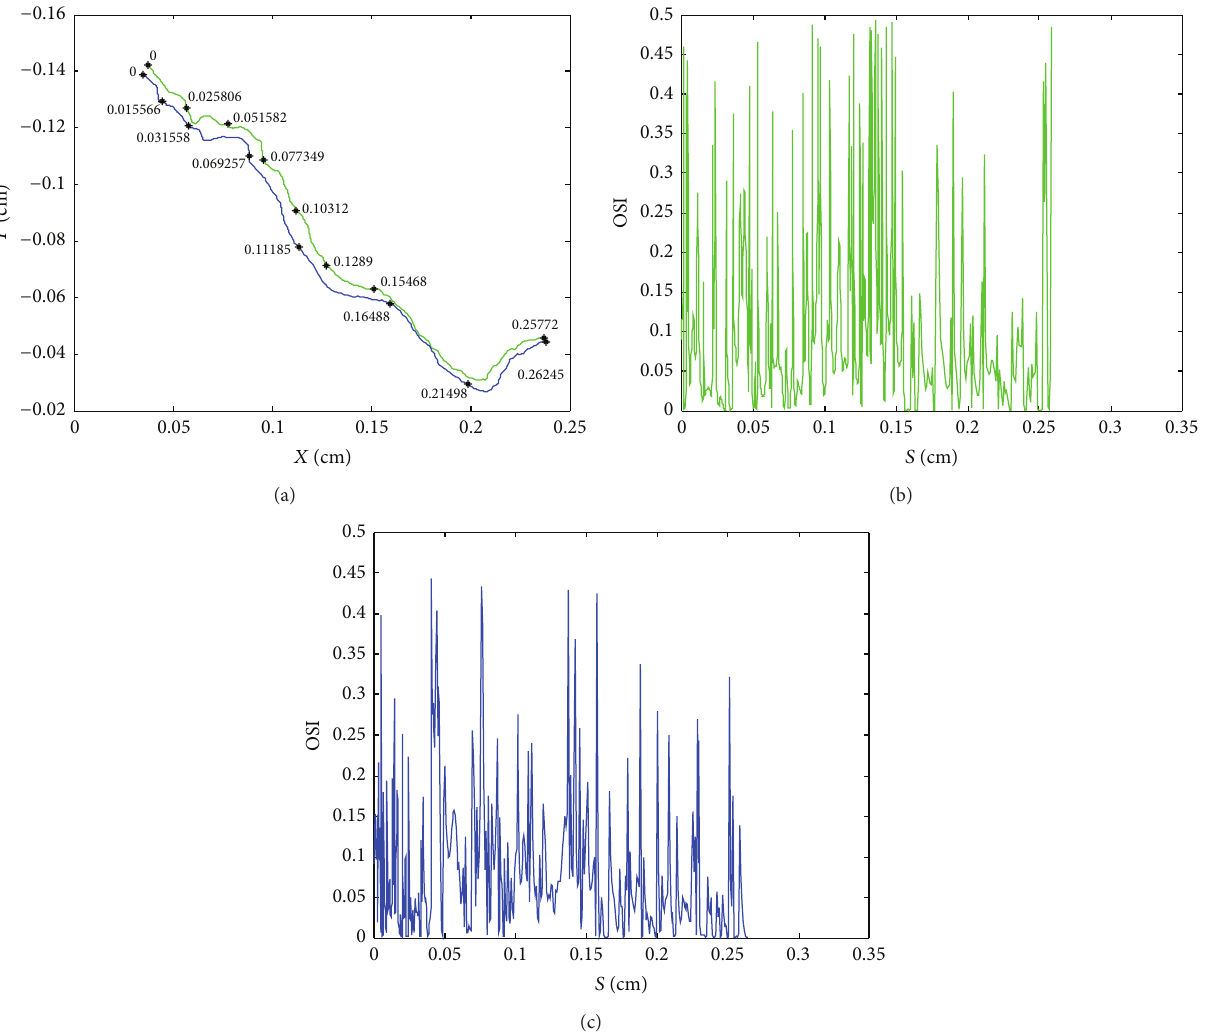
Figure 7: (a) Boundary plots of the coronary arterial walls 1 and 2 shown in green and blue, respectively. (b)-(c) OSI distribution along coronary walls 1 and